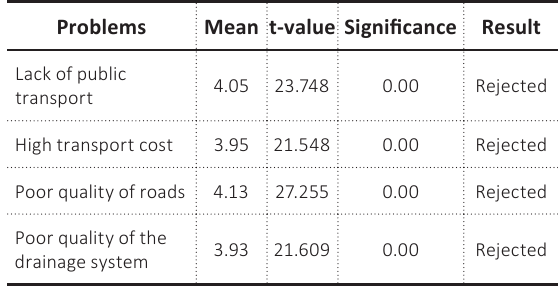
Table 9. Road and transportation